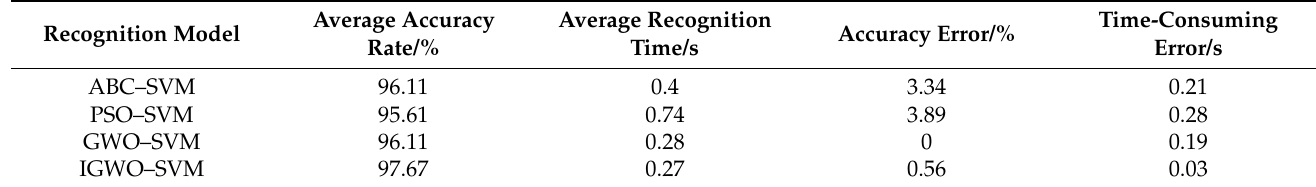
Table 3. Performance comparison of four cutting pattern recognition